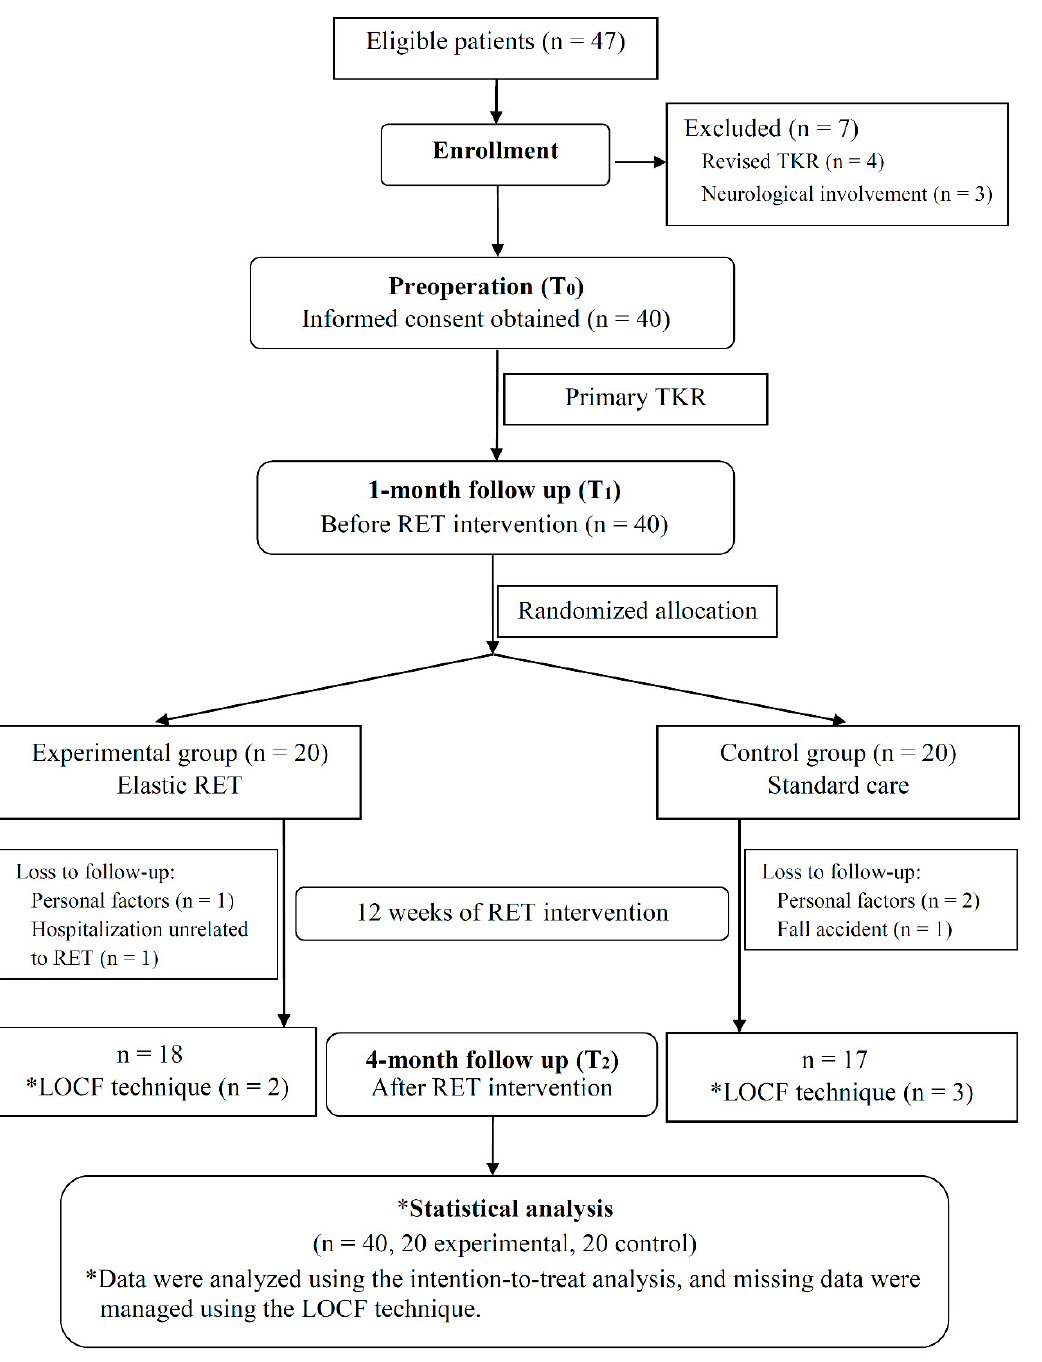
Figure 1. Consolidated Standards of Reporting Trials flowchart for patient enrollment and allocation in the present study. LOCF, last-observation-carried-forward; RET, resistance exercise training; TKR, total knee replacement.